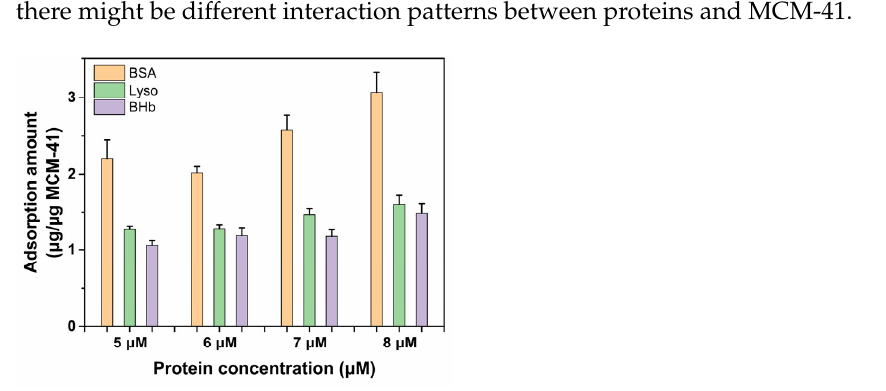
Table 1. The results of the study on MCM ‐ 41 ‐